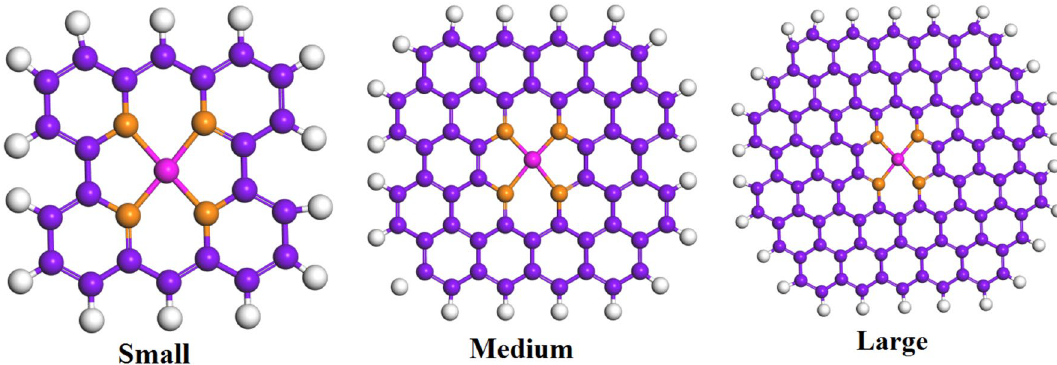
Figure 1. Structures of metal/N-doped carbon of different sizes: Key: C, purple; H, white; N, orange; metal,